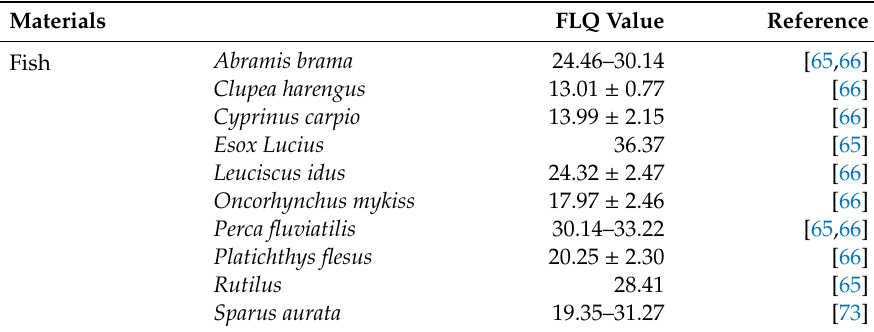
FLQ: fish lipid quality / flesh Lipid quality; * literature from 2000 until April /